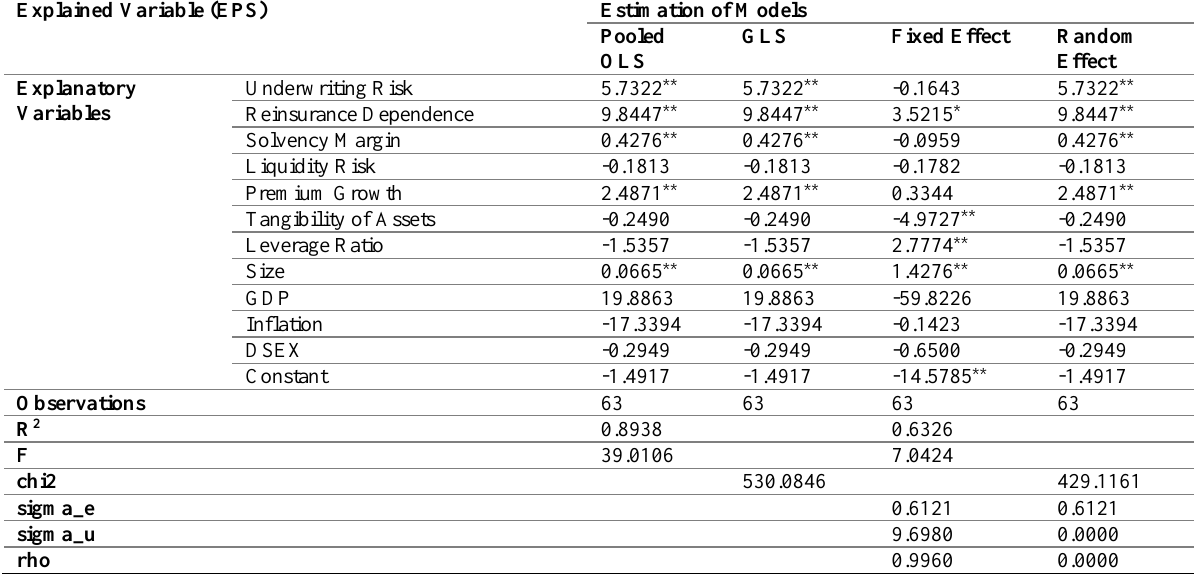
Table 3: Summary of The output of Estimated Coefficients of models based on equation 01, 02 and 03 Explained Variable